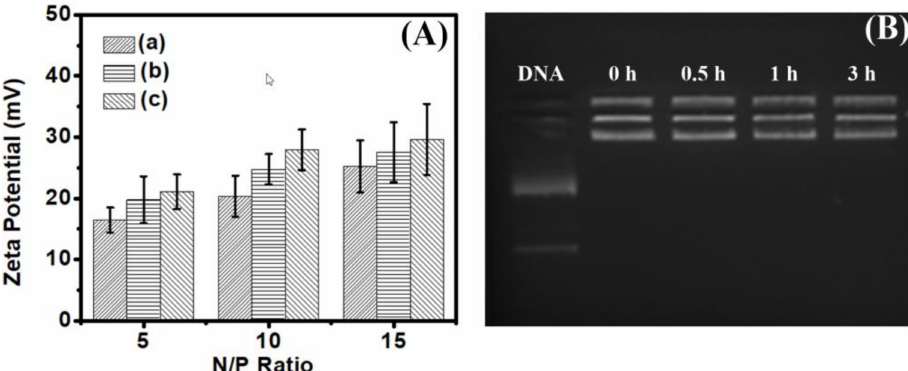
Figure 5. ( A ) Zeta potential of polyplexes of plasmid DNA and (a) poly( L -lysine) 50 - block -poly( L -leucine) 10 , (b) poly( L -lysine) 50 - block -poly( L -leucine) 15 , (c) poly( L -lysine) 50 - block -poly( L -leucine) 25 at different N/P ratio; and ( B ) polyplexes of poly( L -lysine) 50 - block -poly( L -leucine) 25 /DNA digested by trypsin (0.25%) at 37 ◦ C at various